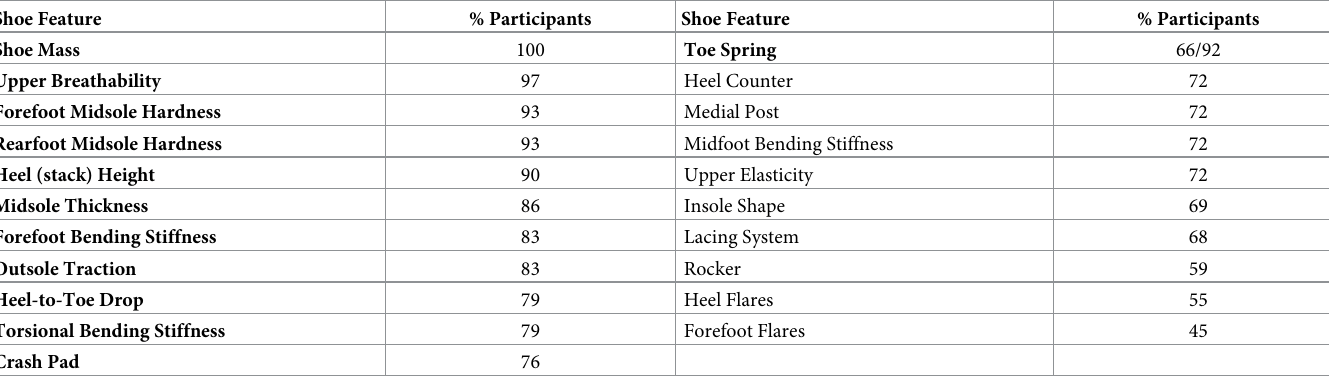
Table 4. Percent of participants that agreed upon the importance of shoe